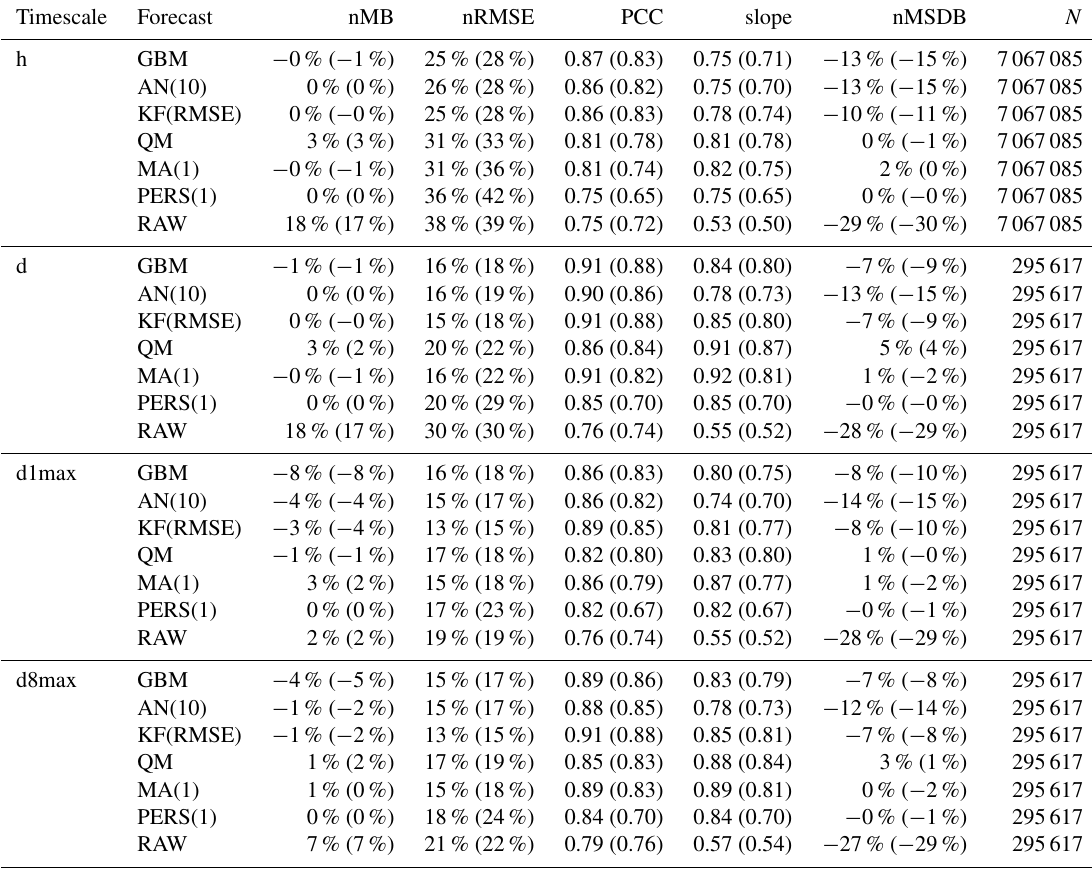
Table 1. Evaluation of the different forecast methods on continuous metrics, at D + 1 (and D + 4 in parentheses), for the h, d, d1max and d8max timescales (see Table S1 in the Supplement for the evaluation results at dd, dd1max and dd8max timescales).